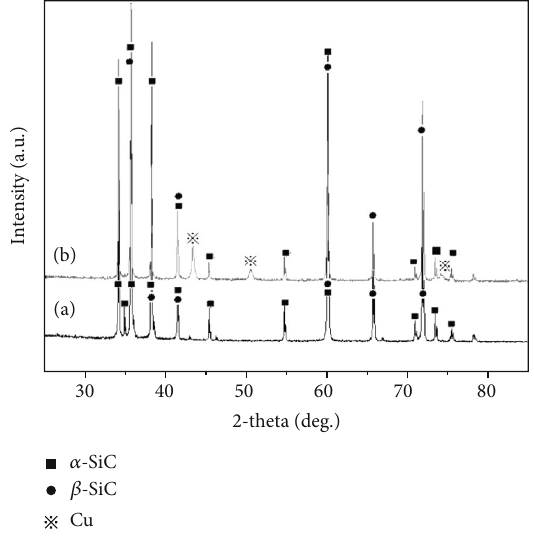
Figure 2: XRD curve of SiC particles and SiC@Cu powder: (a) XRD curve before magnetron sputtering and (b) XRD curve after magnetron